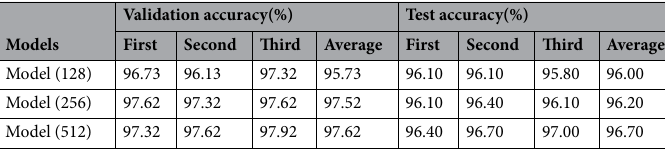
Table 5. Accuracy of the fine-tuning